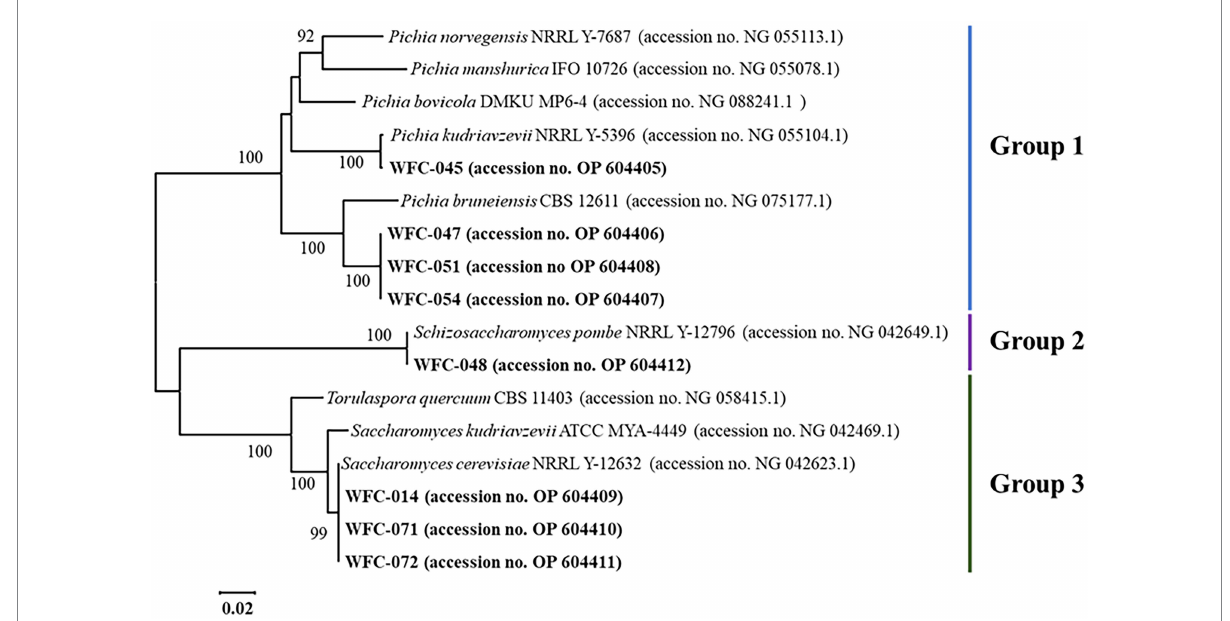
FIGURE 1 Phylogenetic trees of 28S rRNA of